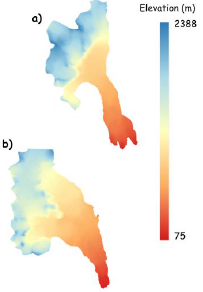
Figure 7. Ice velocity anomaly field for Grey (a, c, e and g) and Tyndall (b, d, f and h), estimated for summer of 2017 (a and b), winter 2017 (c and d), summer 2018 (e and f) and winter 2018 (g and h).